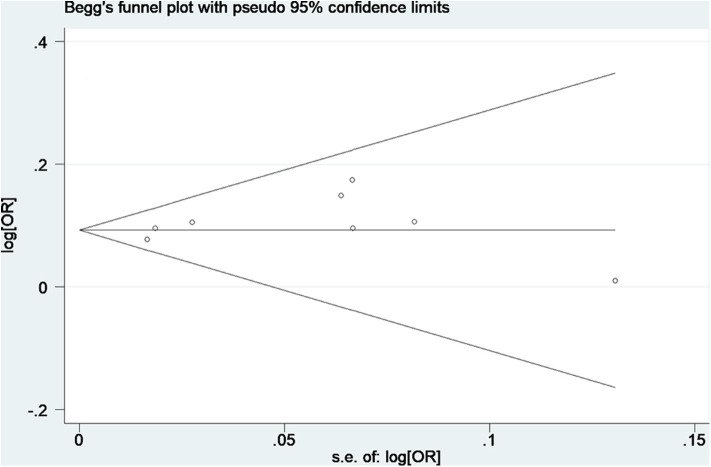
Begg's funnel plot of data from studies on the association of AF with rs13216675. Each point represents a separate study for the indicated association.